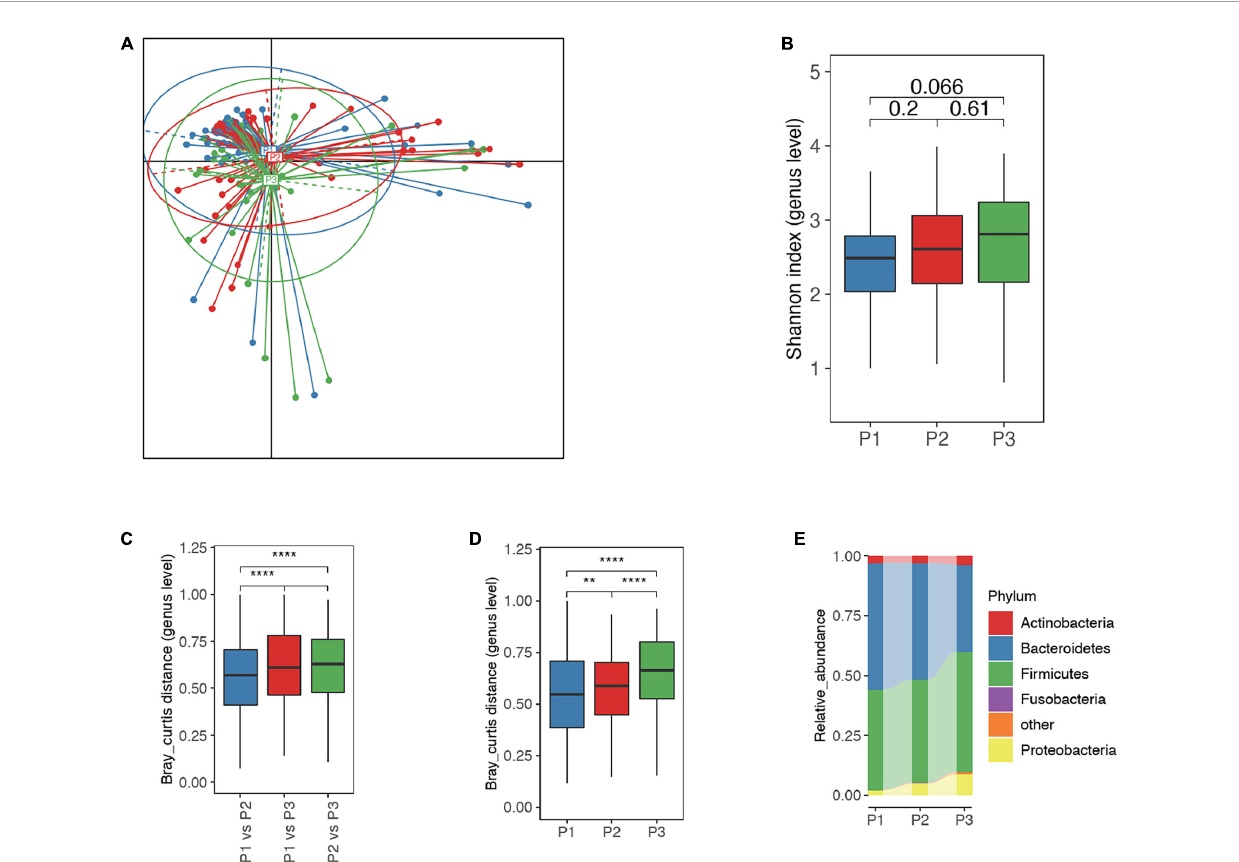
FIGURE2 Overall differences in the gut microbiota (GM) among P1, P2 and P3. (A) Principal coordinate analysis (PCoA) based on Jensen-Shannon divergence as to distance measurement, suggested that microbial distribution in P3 samples differed from those in P1 and P2. (B) Comparison of alpha-diversity for P1, P2, and P3 microbial samples; the number represents adjusted P -value. (C) The Bray-Curtis distance for microbial samples between P1 and P2 was significantly different from the distance between P1 and P3 as well as between P2 and P3, suggesting greater variation in the GM in P3. (D) Inter-individual Bray-Curtis distance of microbial samples at each time point, indicating greater heterogeneity in microbial samples in P3. (E) Phylum-level microbial structure at P1, P2, and P3 timepoints. Bacteroidetes continued to decreased and Proteobacteria to increase commensurate with trimester. P1, P2, and P3 represent the first, second and third trimesters, respectively. The Wilcoxon rank-sum test was applied to analyze the significance of inter-group differences, and the P -value was adjusted with the Benjamini–Hochberg method. **, **** represent adjusted P < 0.01 and P < 0.0001,